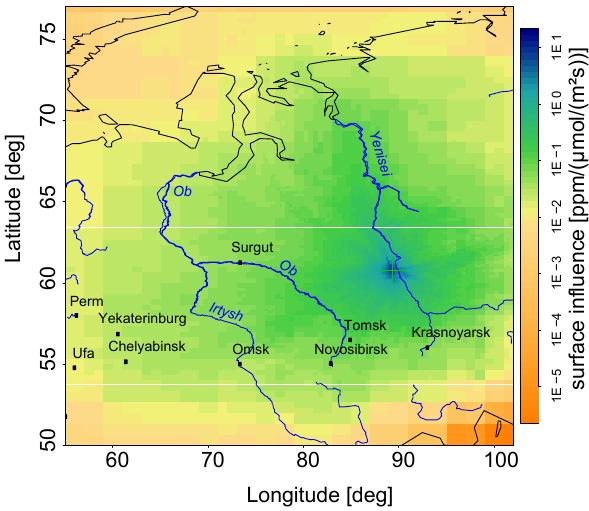
Fig. 1. STILT footprint for ZOTTO 301m level, made from 5 days back trajectories from